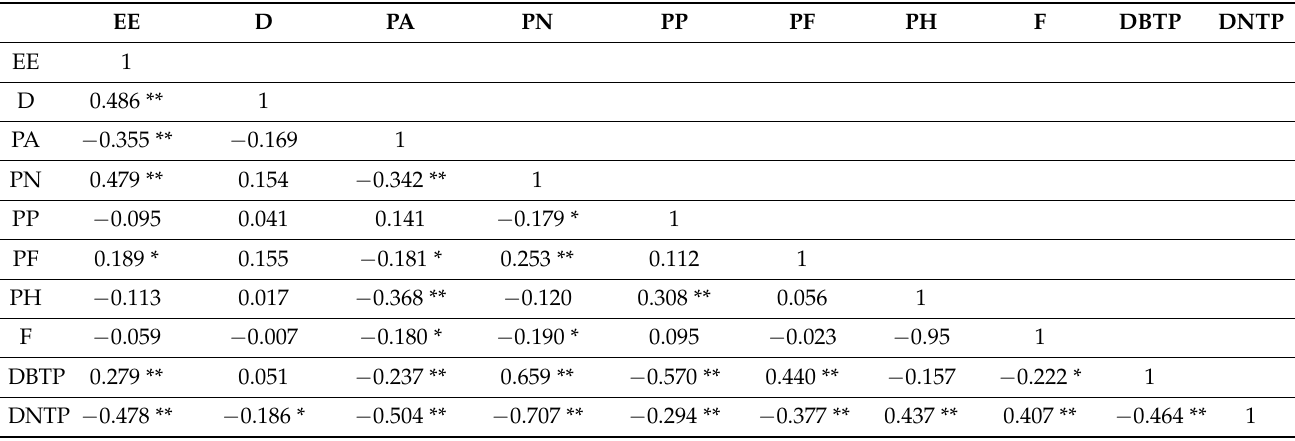
Table 3. Basic linear correlations between